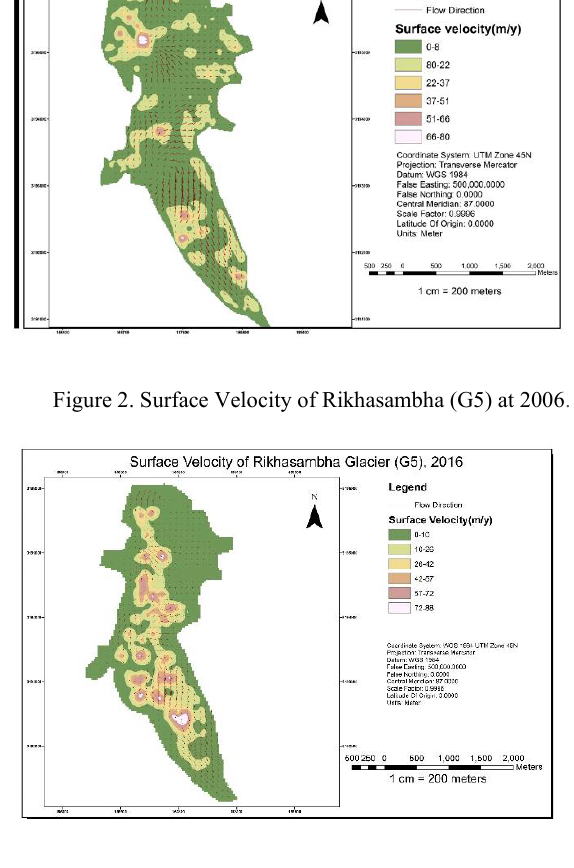
Figure 3. Surface Velocity of Rikhasambha (G5) at 2016.